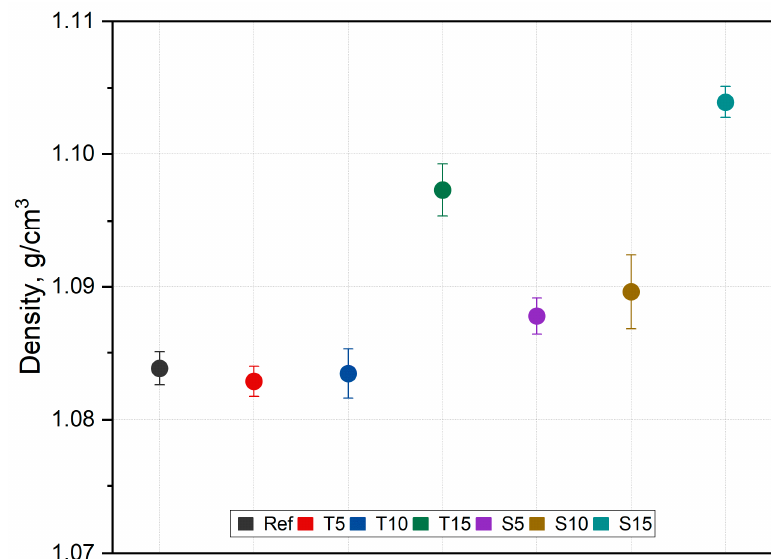
Figure 7. Density results.